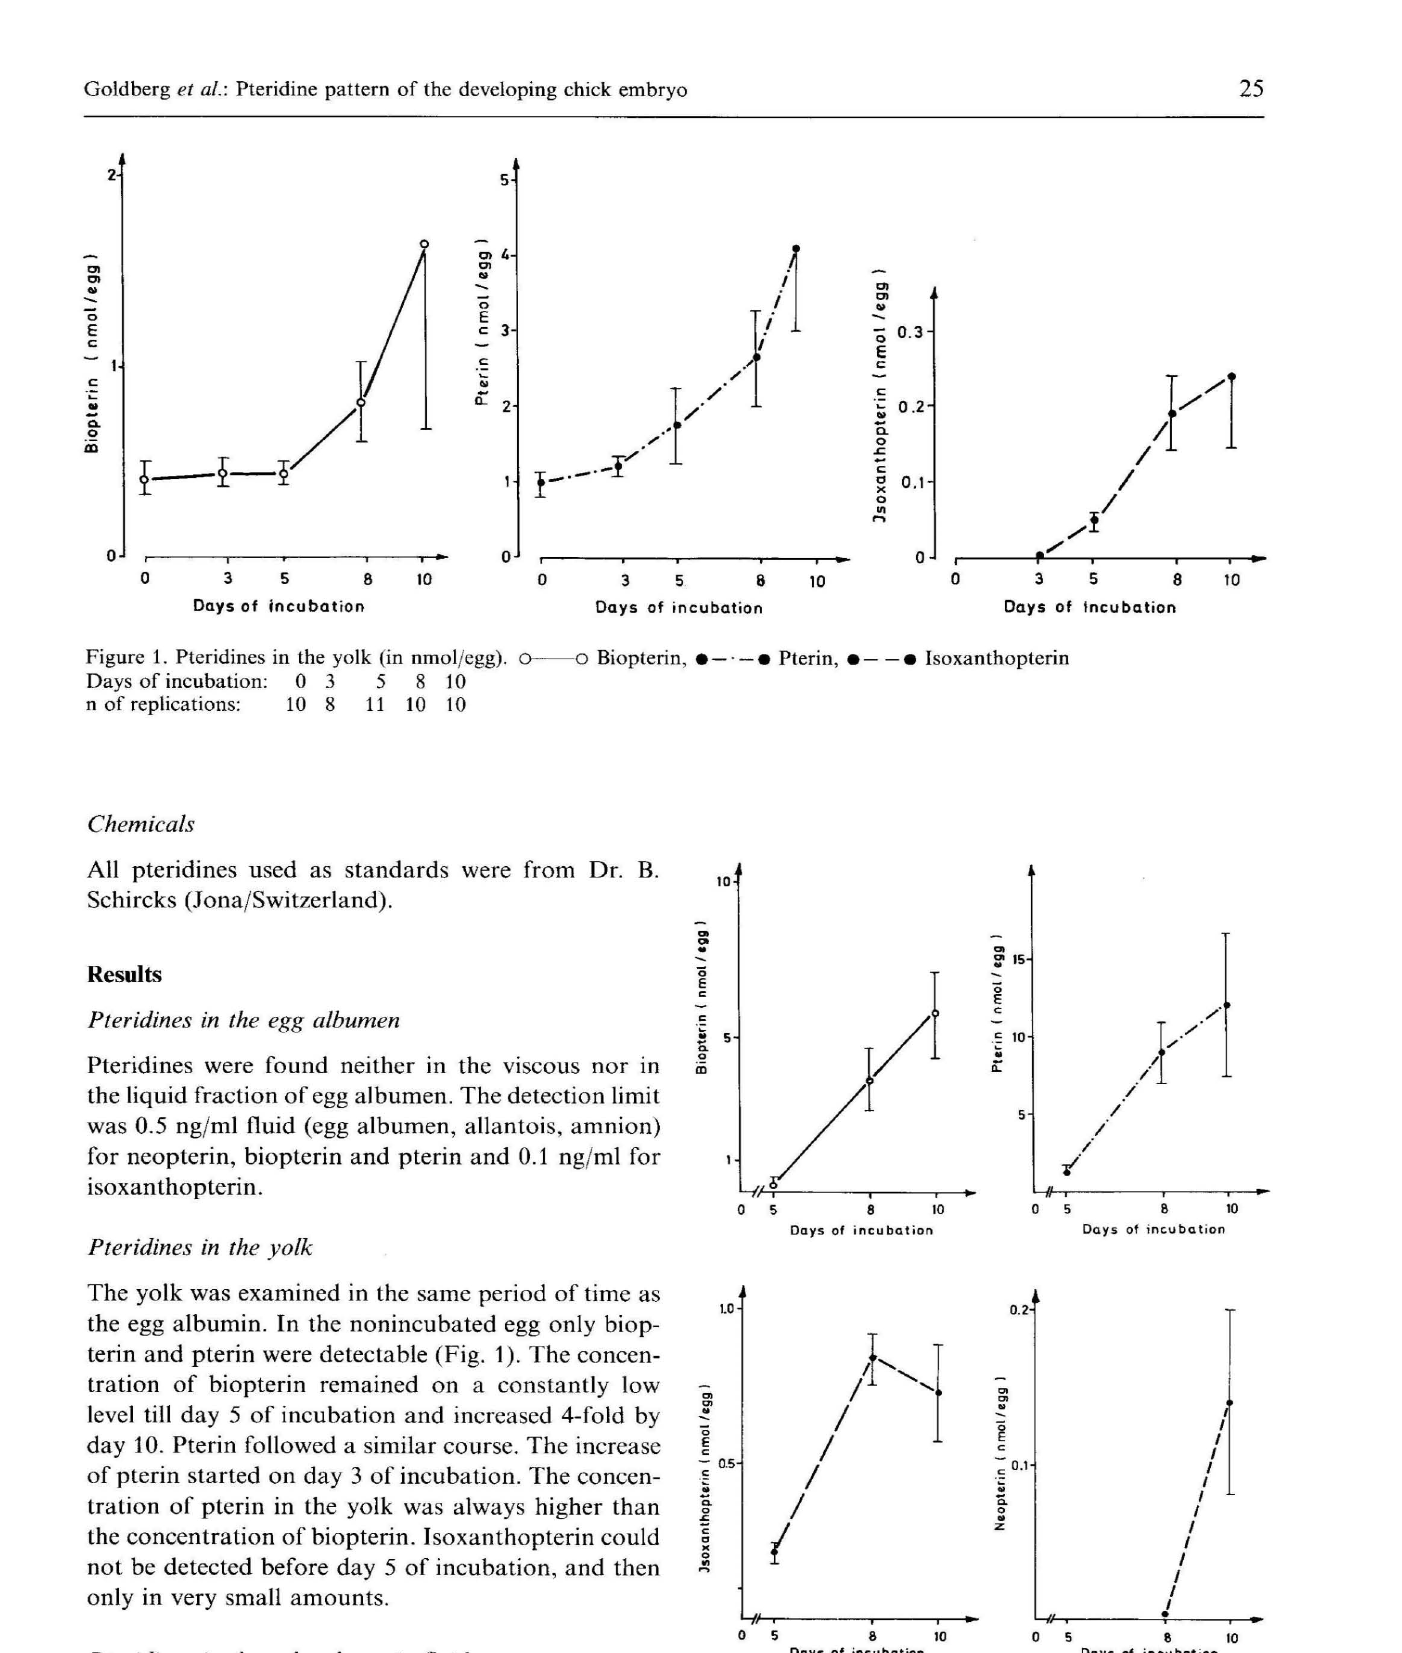
Figure 1. Pteridines in the yolk (in nmol/egg). 0--0 Biopterin, • - ' -. Pterin, • - -. Isoxanthopterin Days of incubation: 0